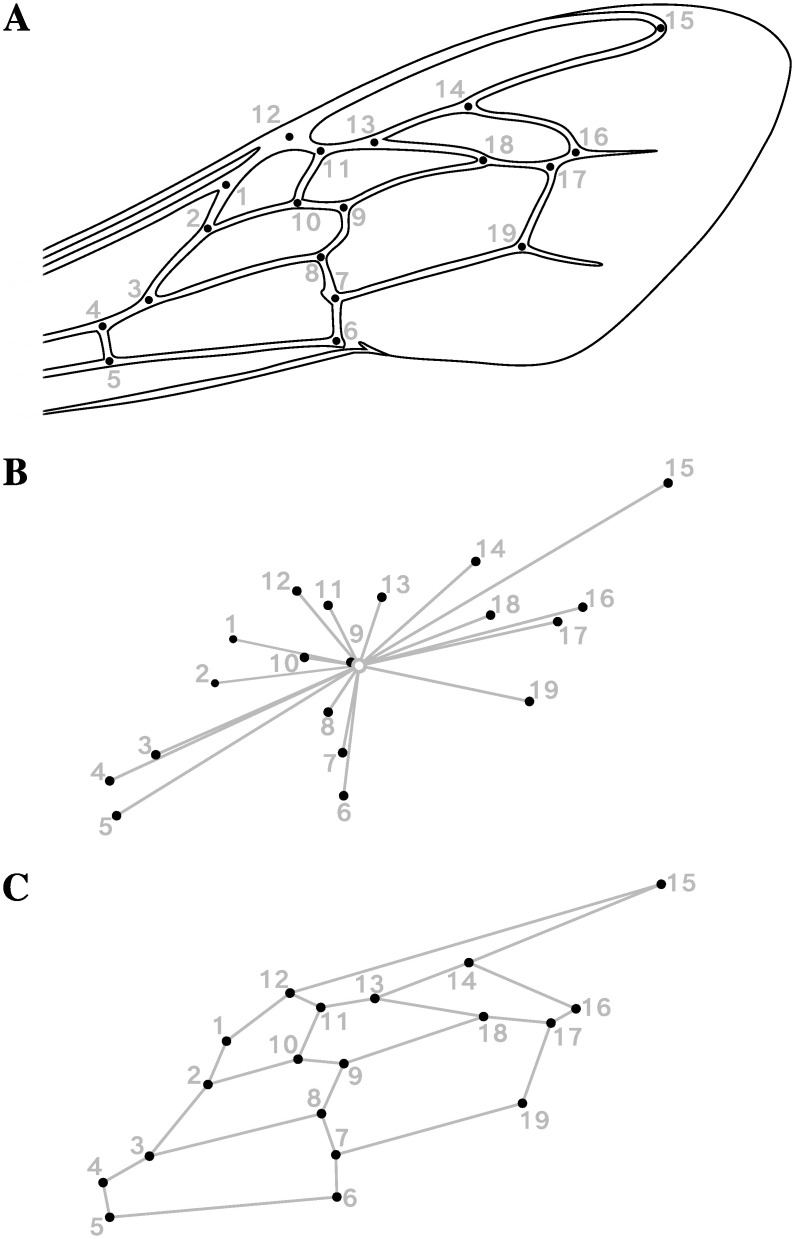
Geometric morphometrics of the forewing venation of honeybee workers (Apis mellifera).(A) Location of the 19 landmarks digitized on the right and (mirrored) left forewings of Apis mellifera workers, following Smith et al. [45] procedure. (B) Visual representation of the centroid size as computed for 19 landmarks on a forewing of Apis mellifera. The open circle is the centroid (i.e. the barycenter) of the landmark configuration; the segments connecting the centroid to the landmarks represent the distances used to compute centroid size. (C) Wireframe visualization of forewing shape. The landmarks are connected with straight lines depicting the wing venation pattern.